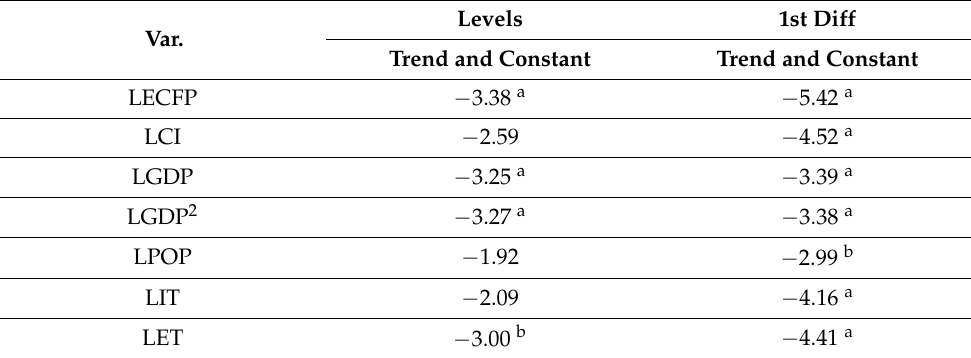
Table 5. Unit root tests overlook the cross-sectional dependence.